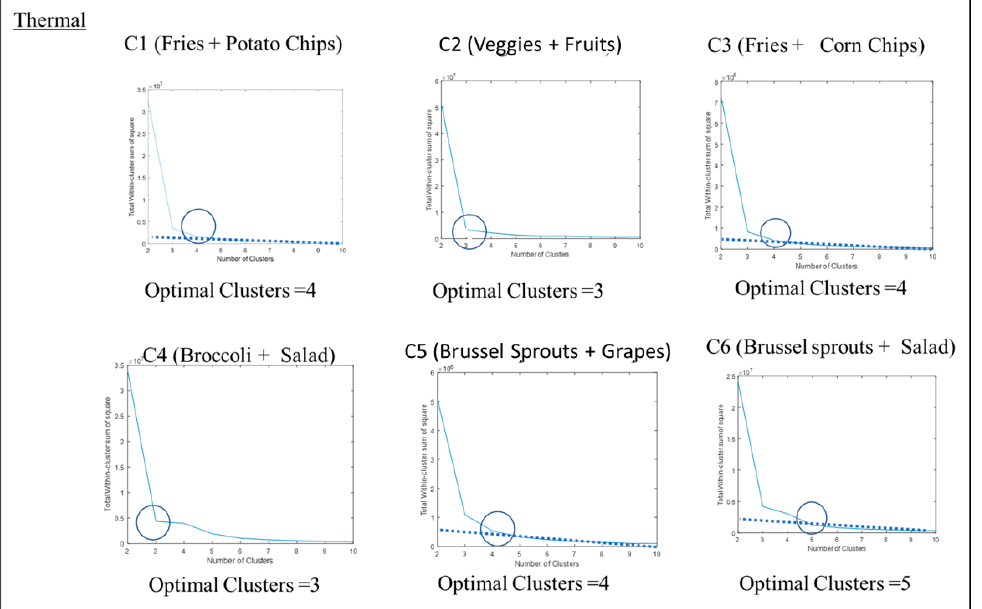
Figure A2. WSS Optimization scheme to determine the number of optimal clusters in RGB data.